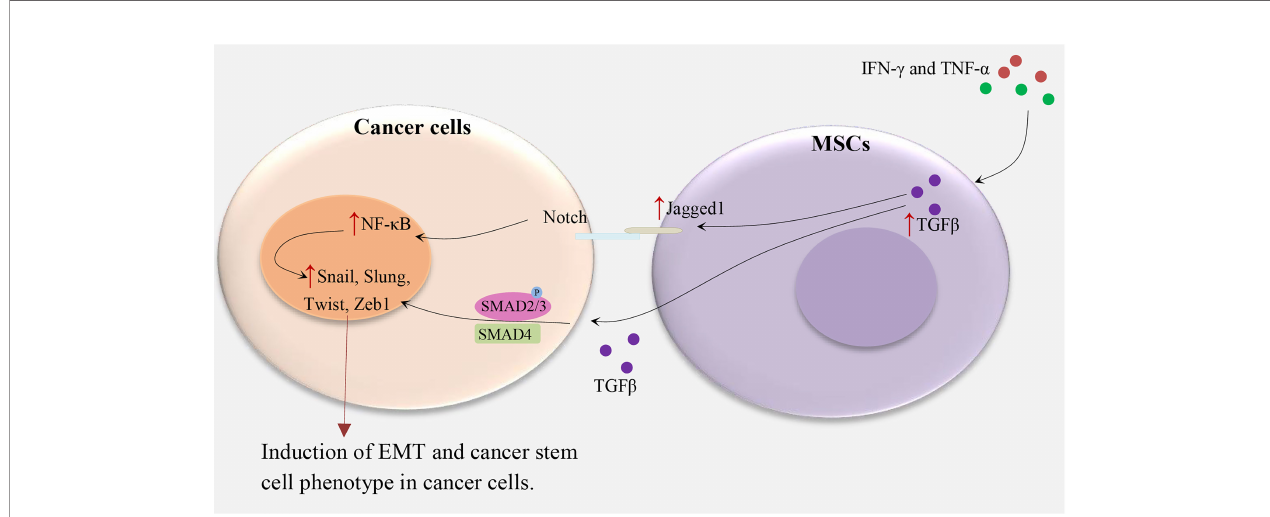
FIGURE 1 | MSCs and induction of CSC phenotype in cancer cells. IFN- g and TNF- a lead to TGF b overexpression in MSCs, subsequently, TGF b upregulates Notch signaling and TGF- b /Smad signaling pathways in cancer cells and induce the cancer stem cell phenotype by upregulating Zeb1, Twist, Slug, Snail, and others which are related to EMT (4, 6, 12, 13).